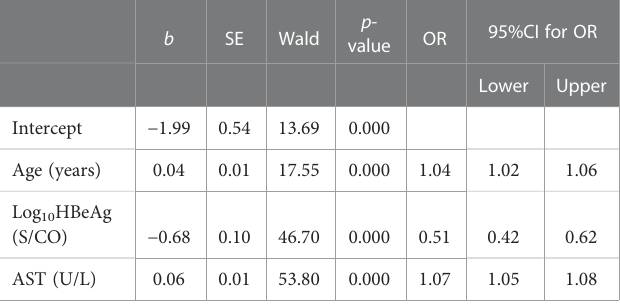
TABLE 3 Multivariate logistic regression analysis of the factors of liver in fl ammation in patients from the primary cohort. p - 95%CI for OR b SE Wald value OR Lower Upper